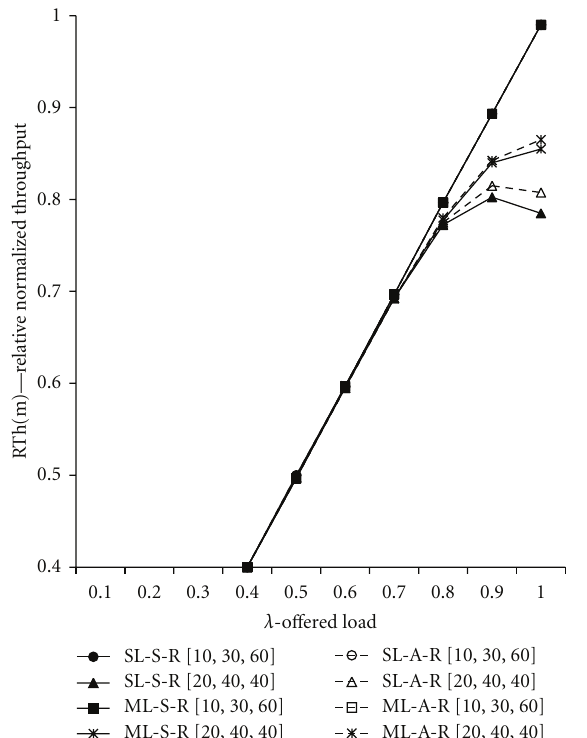
Figure 5: Relative normalized throughput of low-priority packets versus o ff ered